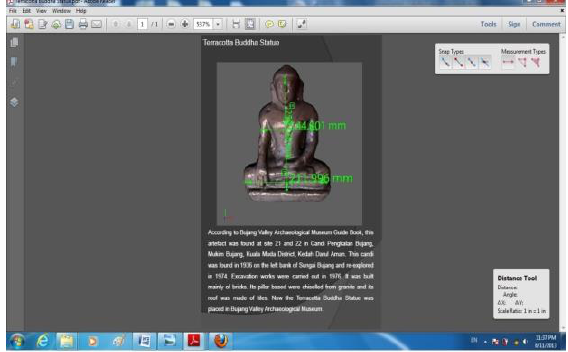
Figure 17. The resulting 3D PDF with embedded 3D terracotta Buddha